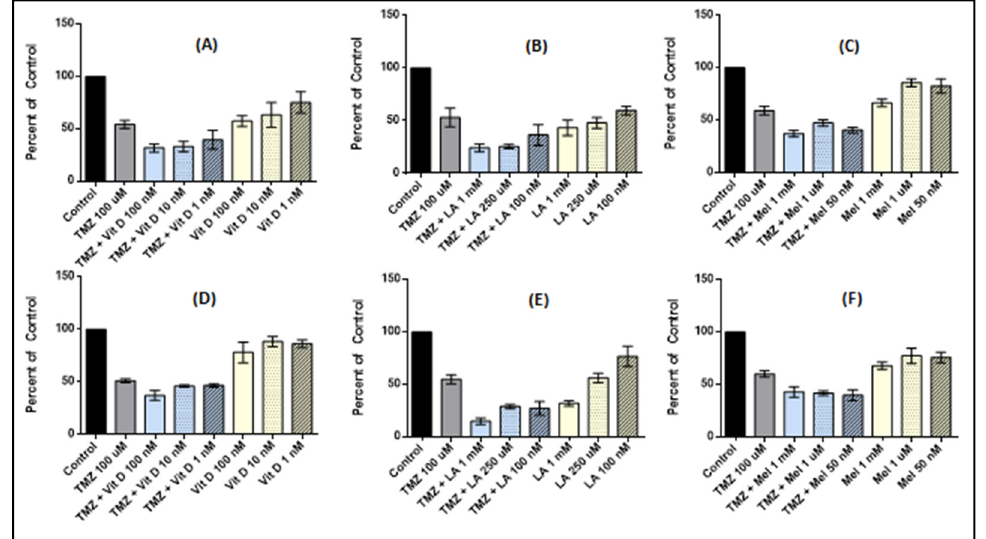
Figure 1. Cell proliferation of U87 ‐ MG ( A – C ) and MU1454 ( D – F ) measured via the MTT assay after serial (“cycled”) 72 h treatments with antioxidants (Vitamin D [VitD], Lipoic Acid [LA], or Melatonin [Mel]) followed by Temozolomide (TMZ) at 100 uM. Dose of TMZ is constant at 100 uM, while dose of antioxidant varies and is indicated on the graph. Error bars represent the 95% confidence interval.